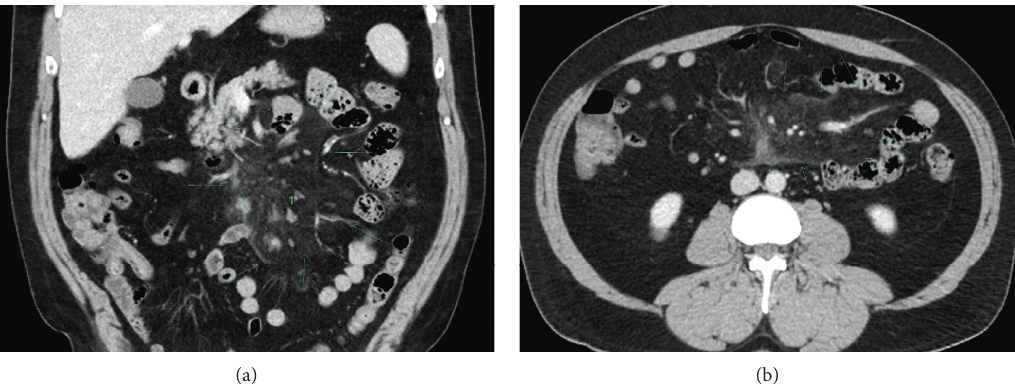
Figure 1: CT abdomen w/contrast: there is moderate “misty” infiltration of the root of the small bowel mesentery (arrows), where an increased number of subcentimeter normal-size mesenteric lymph nodes are also identified. (a) Coronal view. (b) Axial view.